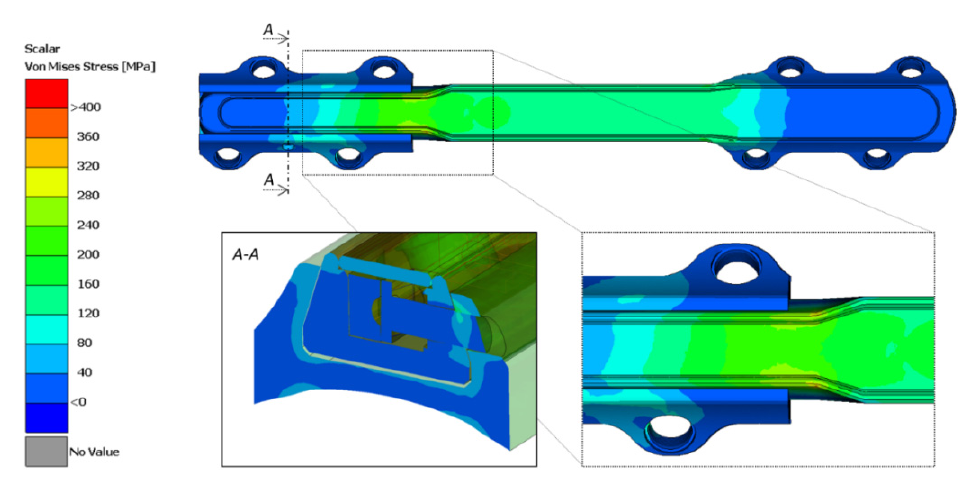
Figure 8. Maximum von Mises stress at the referenced fatigue bending limit (29 Nm): detail of plate components.